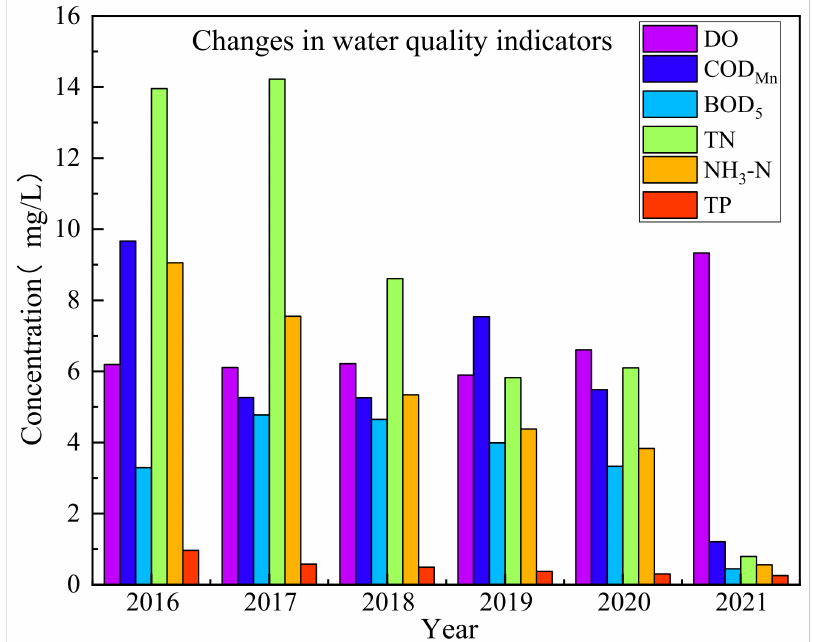
Figure 13. Changes in water quality monitoring indices from 2016–2021. DO, dissolved oxygen; COD Mn , potassium permanganate index; BOD 5 , five-day biochemical oxygen demand; TN, total nitrogen; NH 3 -N, ammonia nitrogen content index; TP, total